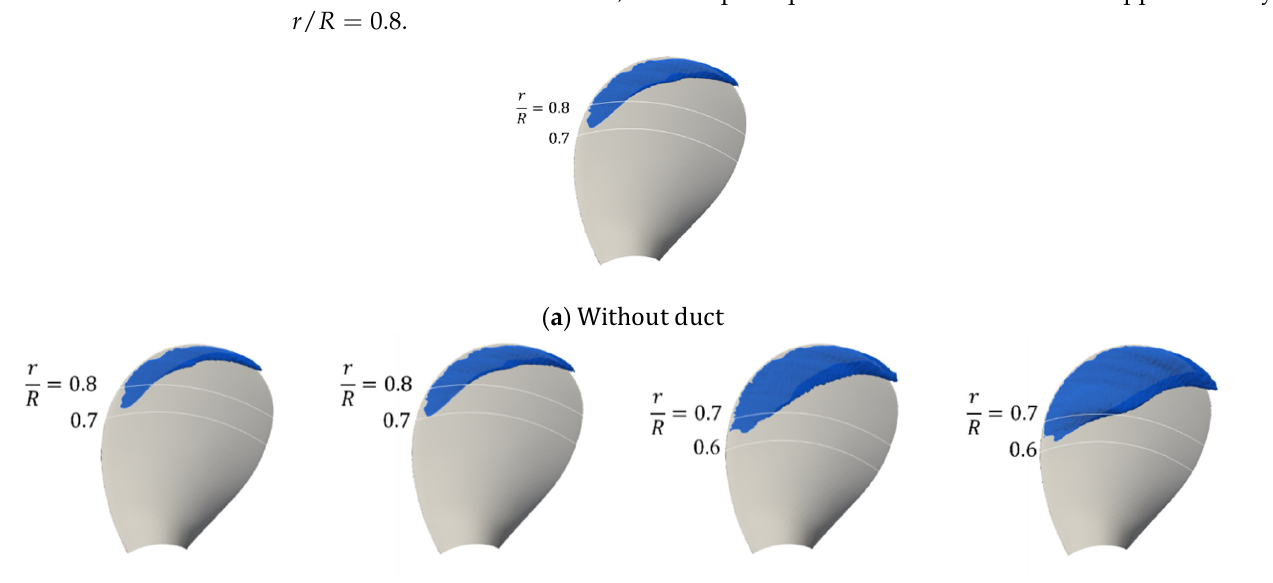
Figure 12. Cavitation of cases with 𝐷 (cid:3005) = 0.7𝐷 (cid:3017) .